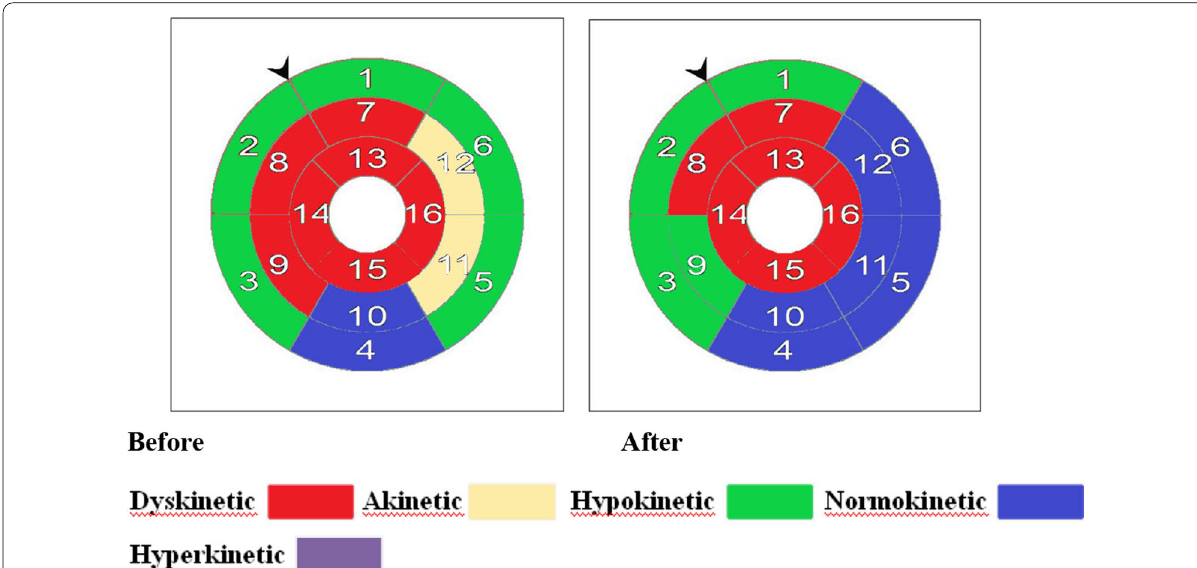
Fig. 4 Patient No. 10 (TG): 43-year-old male patient, smoker with established diagnosis of anterior STEMI, underwent successful primary PCI then enrolled to the TG. By the end of the training program there was an improvement of EF (19 vs. 27) % and WMSI (2.9 VS. 2.4) shown by American heart association (AHA) CMR Bull’s eye plot segmental WMS of the left